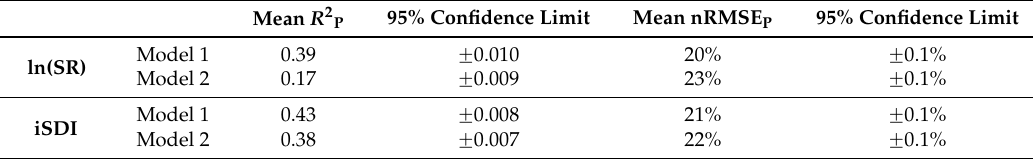
Table 2. Bootstrap results showing the ability of the PLSR models based on the spectral reflectance in the full set of wavebands (Model 1) and the subset of wavebands (Model 2) to predict the species richness (ln(SR)) and the inverse Simpson’s diversity index (iSDI). Mean R 2 P and mean nRMSE P (%) are the average squared correlation coefficients and normalized prediction errors for the validation subset, based on 1000 bootstraps. The 95% confidence limit indicates the upper and lower confidence intervals of the mean values. Mean R 2 P 95% Confidence Limit Mean nRMSE P 95% Confidence